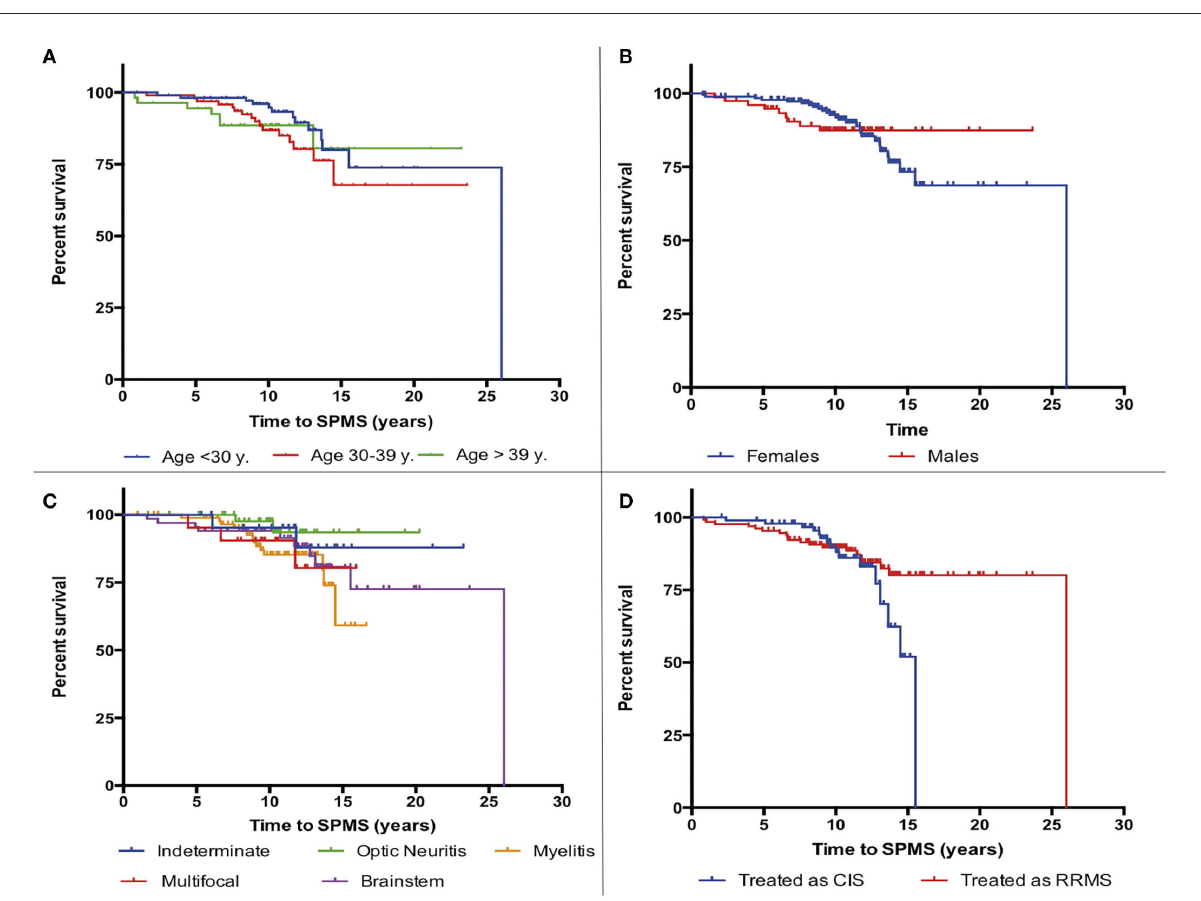
FIGURE2 Kaplan-Meier survival analysis of the time to reach a diagnosis of secondary progressive multiple sclerosis (SPMS) according to demographic and clinical characteristics. (A) Age at first symptom, (B) sex, (C) initial clinical syndrome, and (D) be treated as clinically isolated syndrome (CIS) or as relapsing-remitting multiple sclerosis